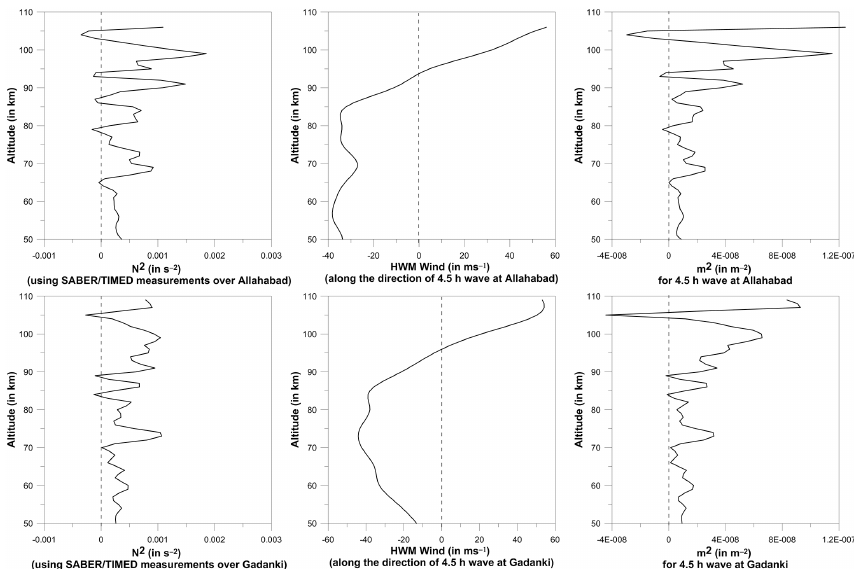
Figure 8. Altitude variation of the square of Brunt–Vaisäla frequency ( N 2 ) (left panel), the HWM wind ( U ) along the propagation direction of 4.5h wave (middle panel), and the squared vertical wave number (m 2 ) (right panel). Results for Allahabad and Gadanki are presented in the top and bottom panel,